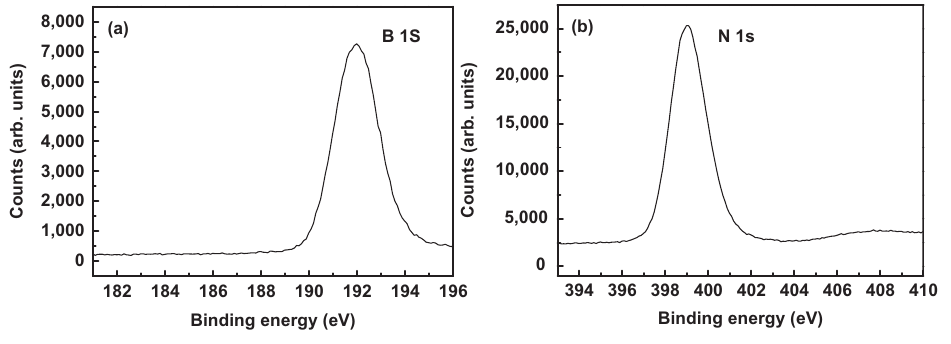
Figure 3: XPS spectra of (a) B 1s and (b) N 1s for BN